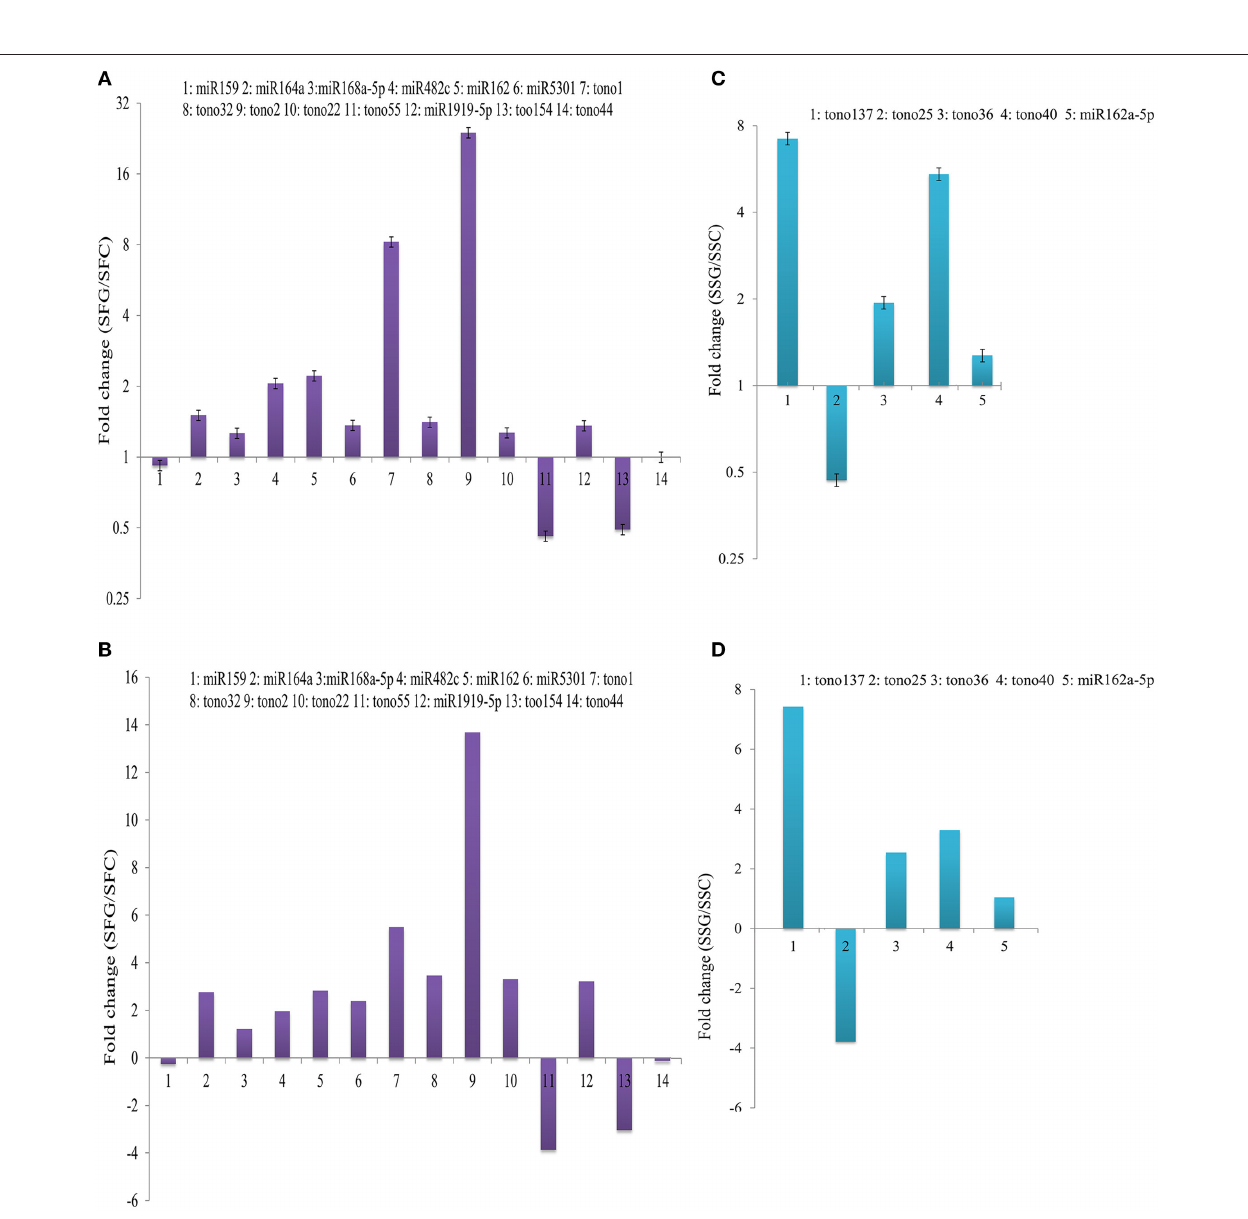
Frontiers in Plant Science |